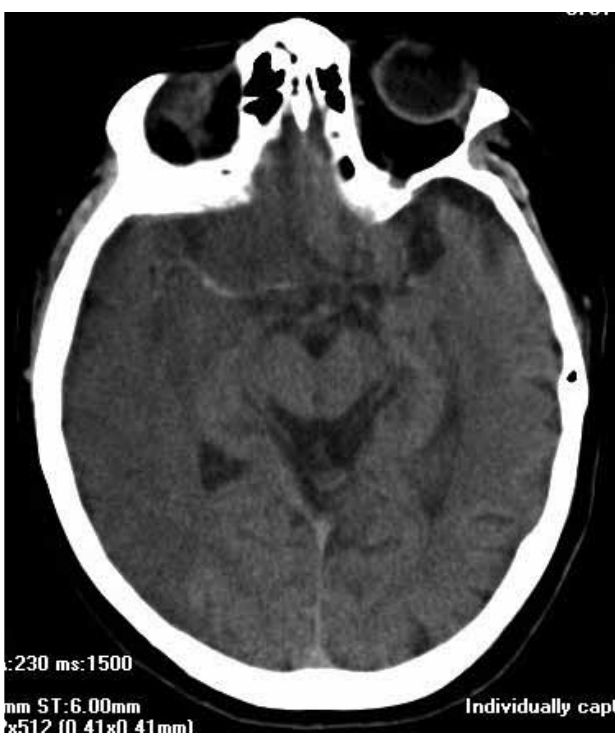
Fig. 1. HMCA sign. Non-enhanced axial CT brain (at the level of the suprasellar cistern) in a patient with sudden onset left hemiparesis demonstrates hyperattenuation (measuring 82 HU) of the right middle cerebral artery, which is suggestive of occlusion of this artery and is an indirect sign. There is also diffuse hypodensity of the right temporal lobe, a direct sign of ischaemic